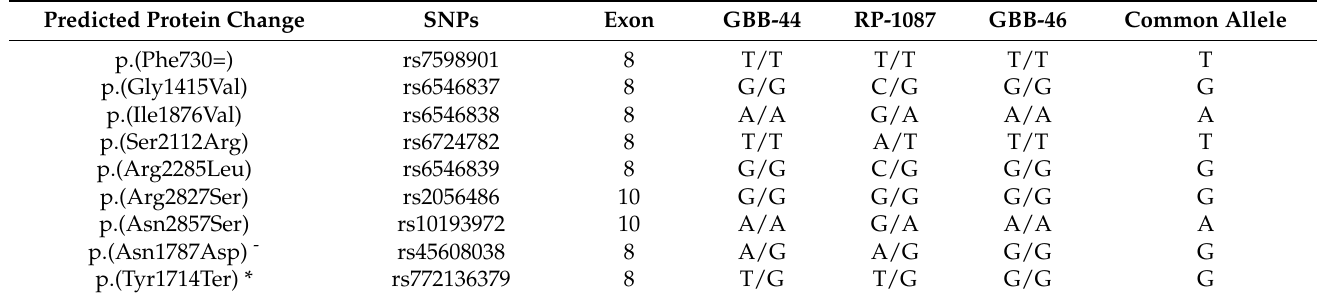
Table 4. Haplogroup classification of Alström patients with the pathogenic variant p.(Tyr1714Ter). Analyzed SNP, predicted protein change, exon in which they are found, genotype of the study individuals and shared common allele. Predicted Protein Change SNPs Figure 2. Different relative allele frequencies for the pathogenic variants detected in the cohort, expressed as a fraction of total alleles ( N = 24).